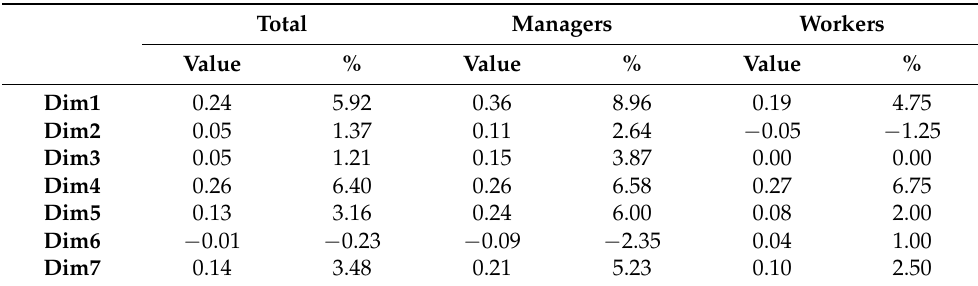
Table 6. Discrepancies emerged for each dimension of the NOSACQ-50 questionnaire between the current study and previous research [8].